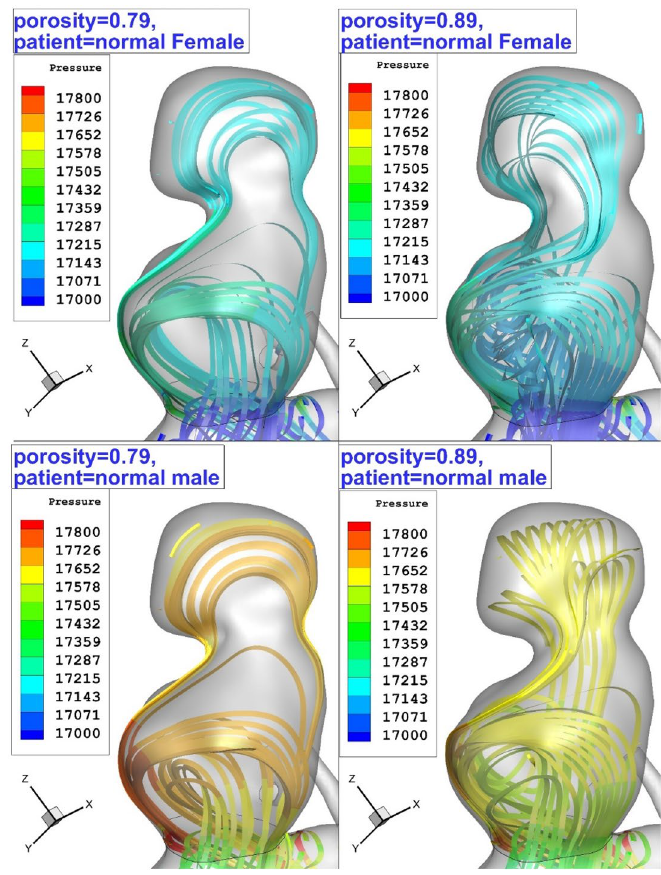
Figure 14. Blood stream patter inside the aneurysm in different HCTs and Coiling porosities.